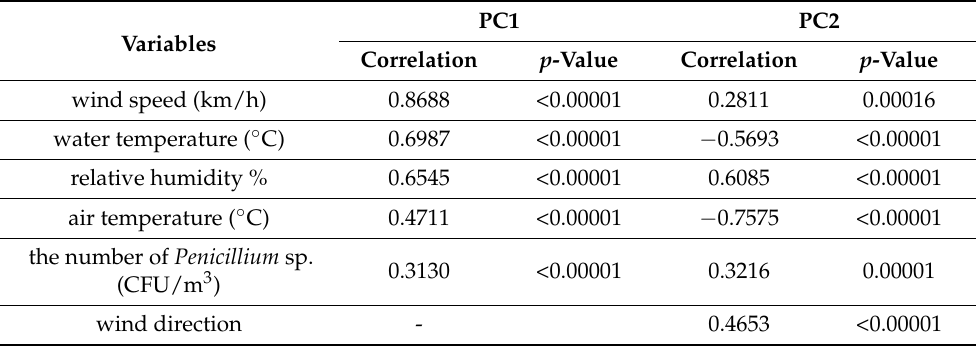
Table 6. The values of the correlation between PC1, PC2, and the variables used to build the